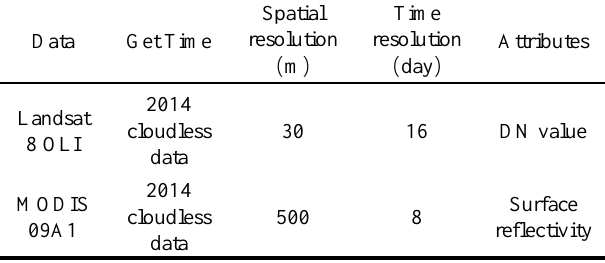
Table 1.The list of data used in the study